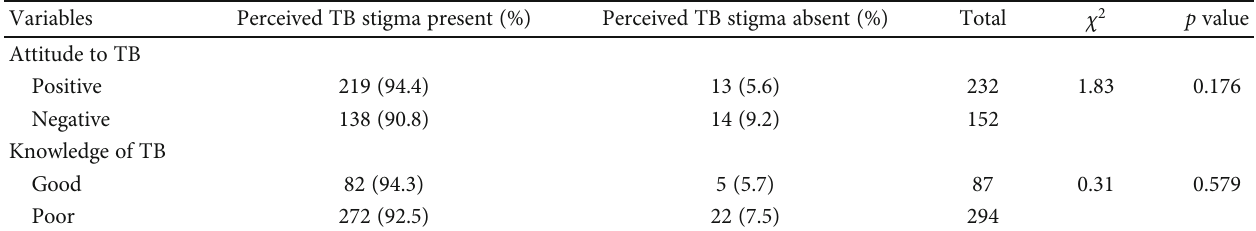
(a) Association between respondent knowledge and attitude and perceived TB-associated stigma in rural communities